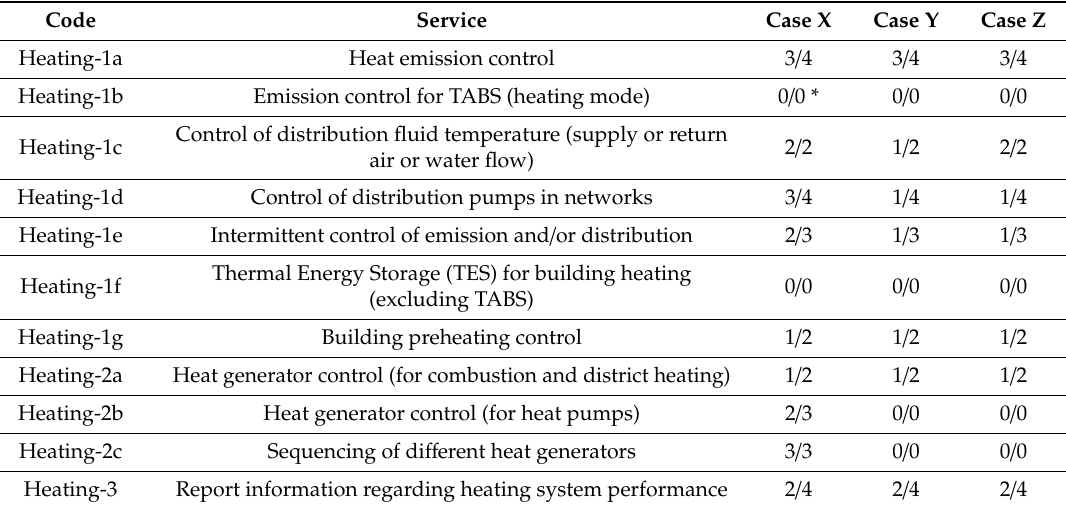
Table 3. The functionality levels in the main domain of heating.